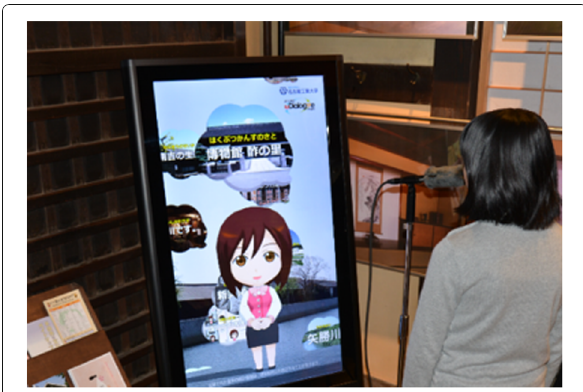
Fig. 11 Proposed system at Handa Tourist Information Center